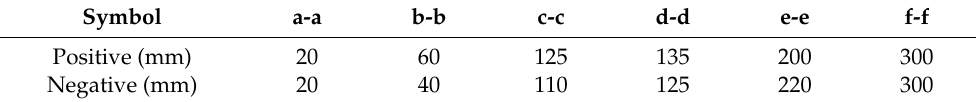
Figure 13. Variations in the MVOIAF with WP and the feed velocity. Table 3. Position corresponding to the symbols a-a to f-f in Figure 12.